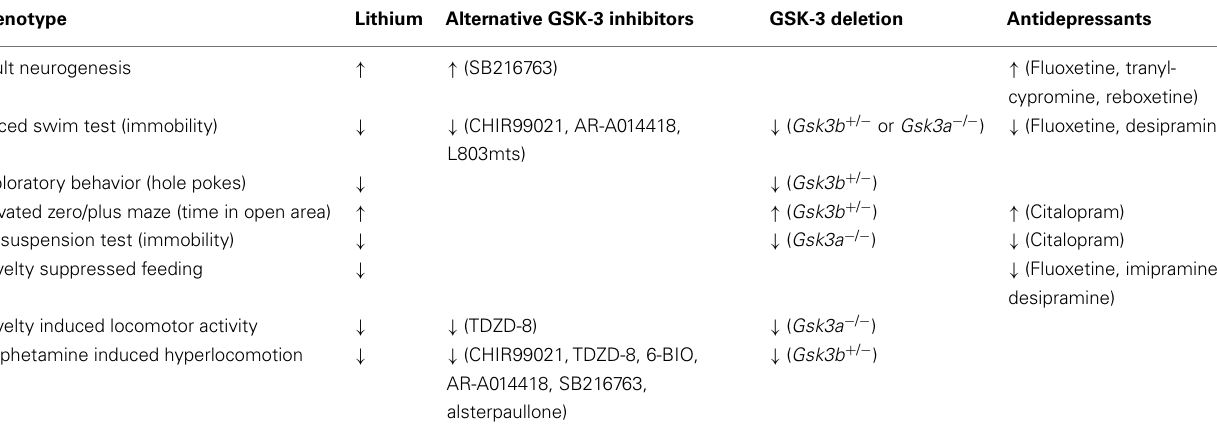
Table 2 | Parallels between GSK-3 inhibitors and antidepressants in adult neurogenesis and